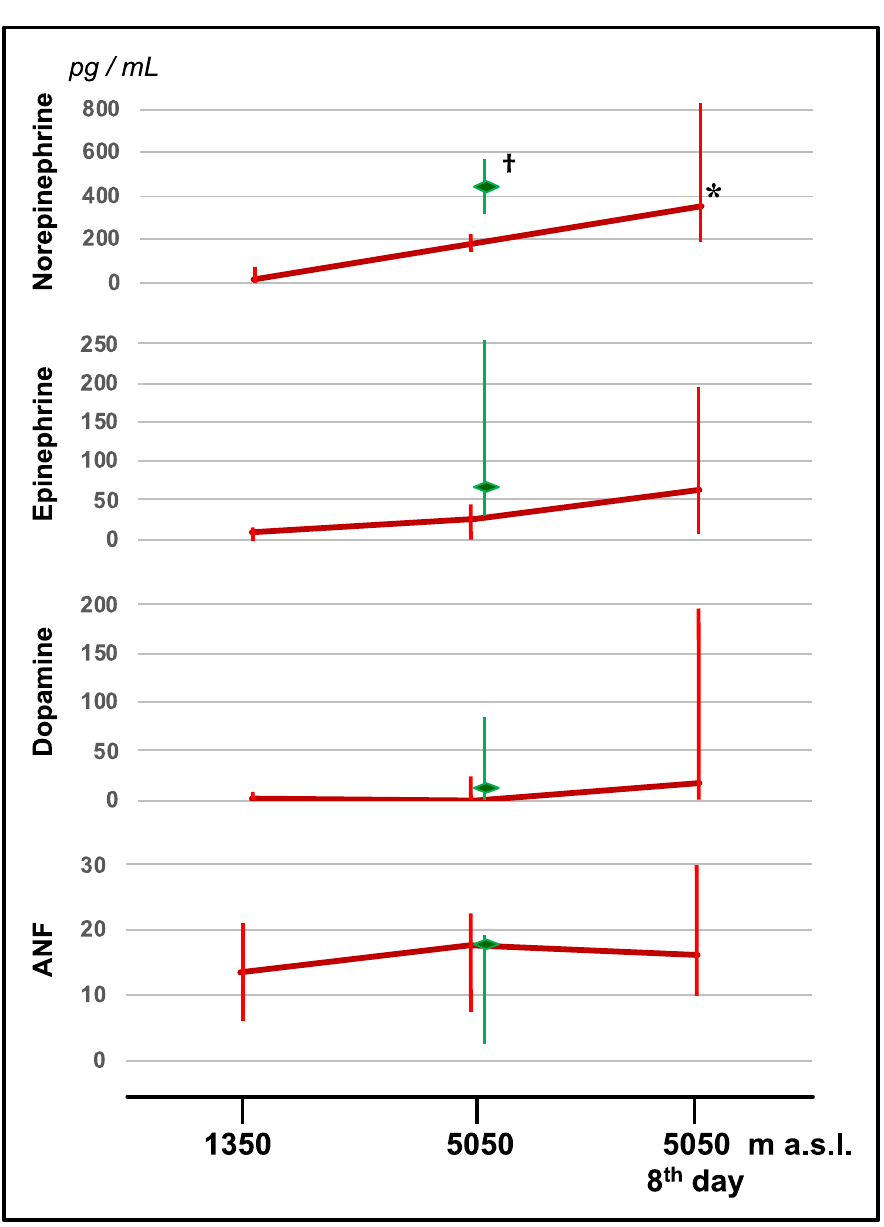
Figure 5. Changes in norepinephrine, epinephrine, dopamine, and atrial natriuretic factor values in lowlanders (red lines) with altitude. Data recorded in highlanders at 5050 m a.s.l. are shown as green lines. Data are shown as median and interquartile range. a.s.l., above sea level. Significance is expressed by the p -value: *, p < 0.05 versus values at 1350 m a.s.l.; †, p < 0.05 highlanders versus lowlanders.